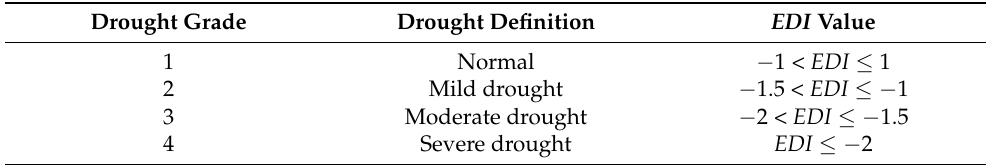
Table 1. Drought classes of meteorological drought